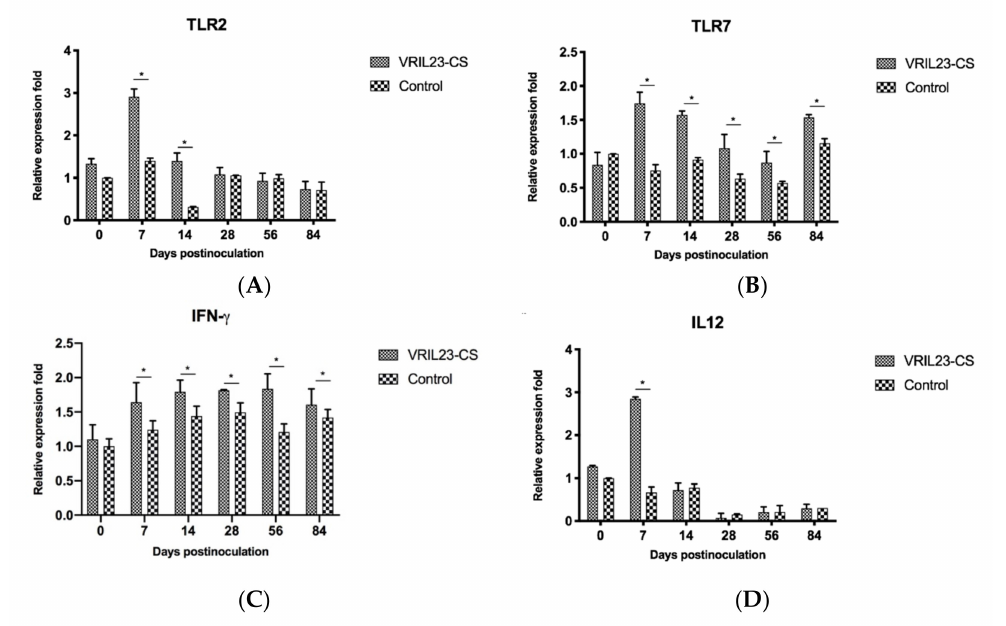
Figure 10. Gene expression levels of TLR2, TLR7, IFN- γ , and IL12 in immune cells of the blood of experimental pigs. ( A ) TLR2; ( B ) TLR7; ( C ) IFN- γ ; ( D ) IL12. * indicates the di ff erence between the two groups is significant, p <